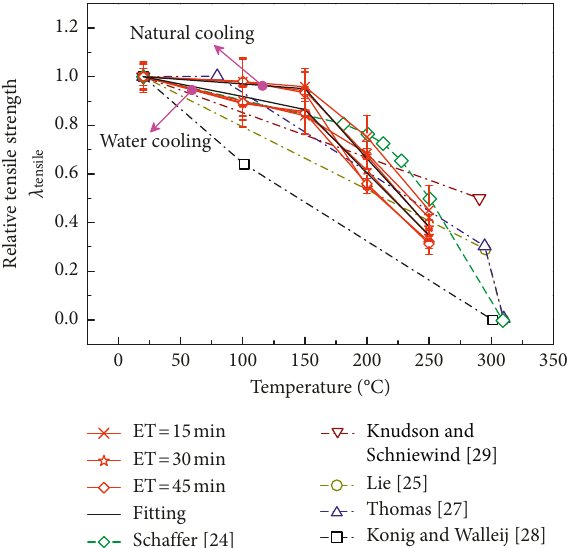
exposure (cid:31) Figure 10: Relative tensile strength parallel to grain as a function of exposure temperature (ET exposure time). (cid:31)